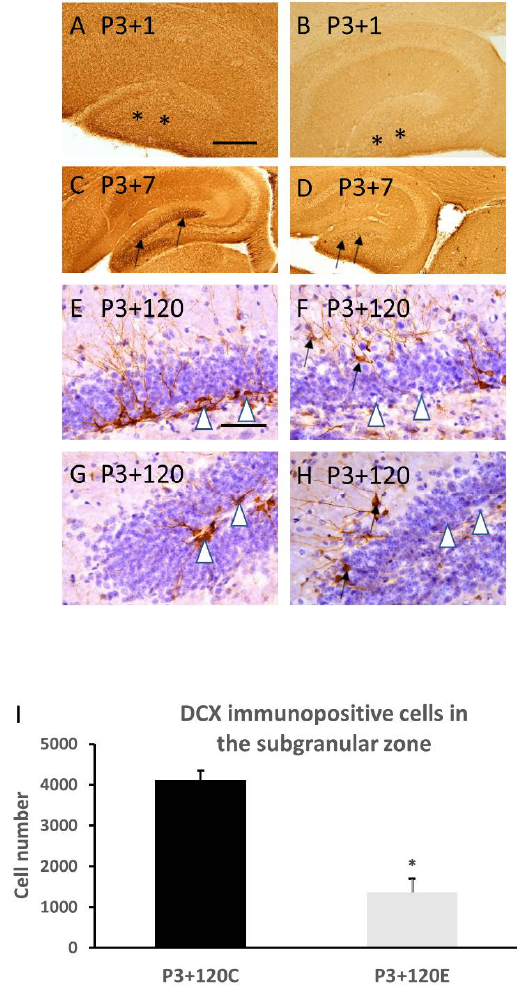
Figure 4. DCX immunostaining shows that γ -irradiation with 5Gy at postnatal day 3 induced an obvious reduction in DCX immunopositive product in the dentate gyrus at 1 day (( B ) compared to ( A ) in the control, asterisks) and 7 days (( D ) compared to ( C ) in the control, in particular in the subgranular zone, arrows indicate DCX immunopositive cells). Quantitative study indicates a significant reduction in DCX immunopositive neurons in the subgranular zone of the dentate gyrus at 120 days after radiation exposure (white arrowheads in ( F ), ( H ) indicate subgranular zone with fewer DCX immunopositive cells compared to those in ( E , G ) which indicate more DCX immunopositive cells. ( I )). Aberrant DCX immunopositive neurons also appeared in the molecular layer of the dentate gyrus at 120 days after radiation exposure (arrows in ( F , H )) ( n = 5). * p < 0.05 vs P3+120C. Scale bar =200 µ m in ( A ) applies to ( B – D ). Scale bar = 100 µ m in E applies to ( F – H